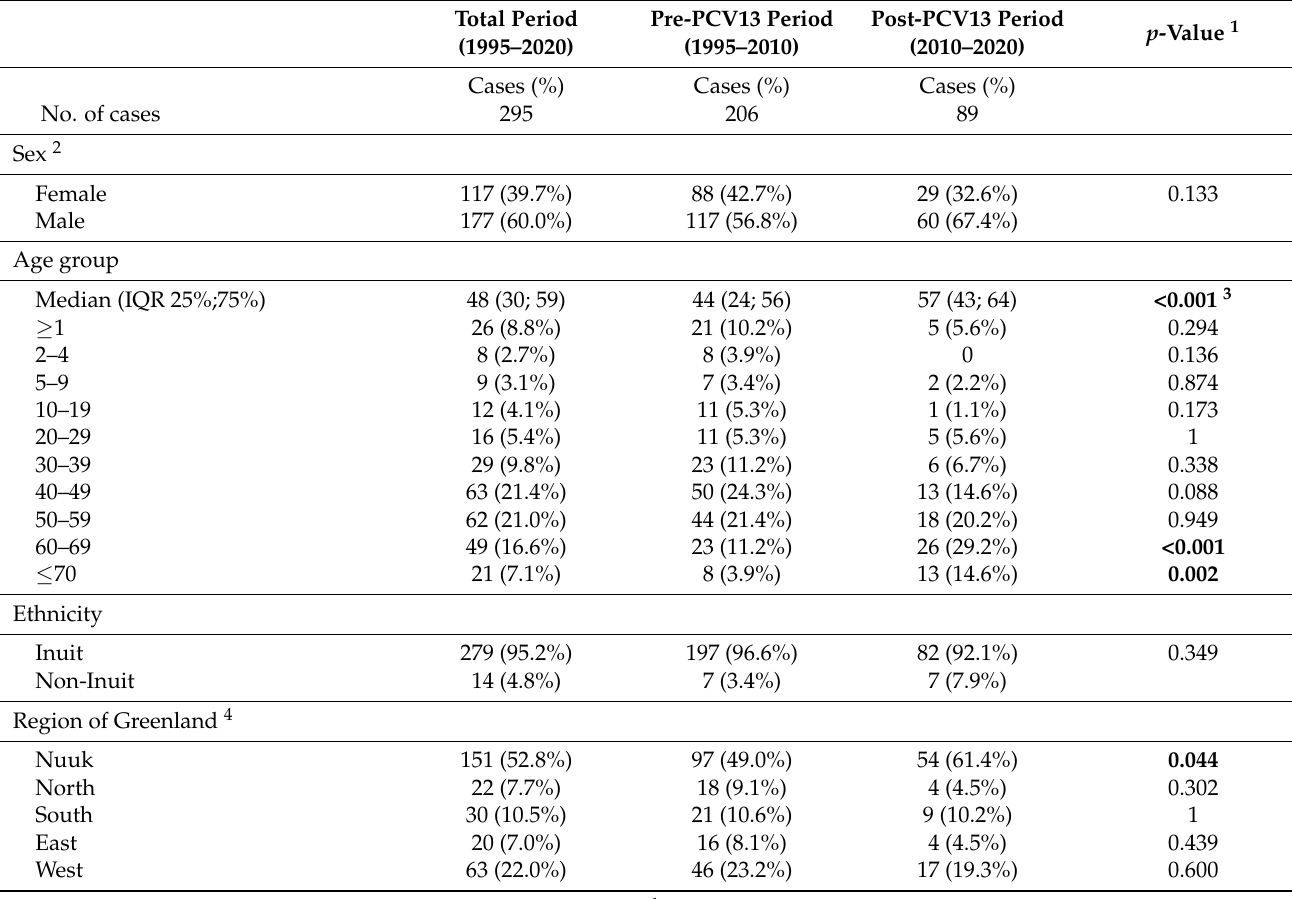
Table 1. Demographic characteristics of 295 patients with invasive pneumococcal disease (IPD) in Greenland 1995–2020, overall, pre (1995–2010), and post (2010–2020) introduction of the 13-valent pneumococcal conjugate vaccine (PCV13) to the childhood vaccination program in 2010 in